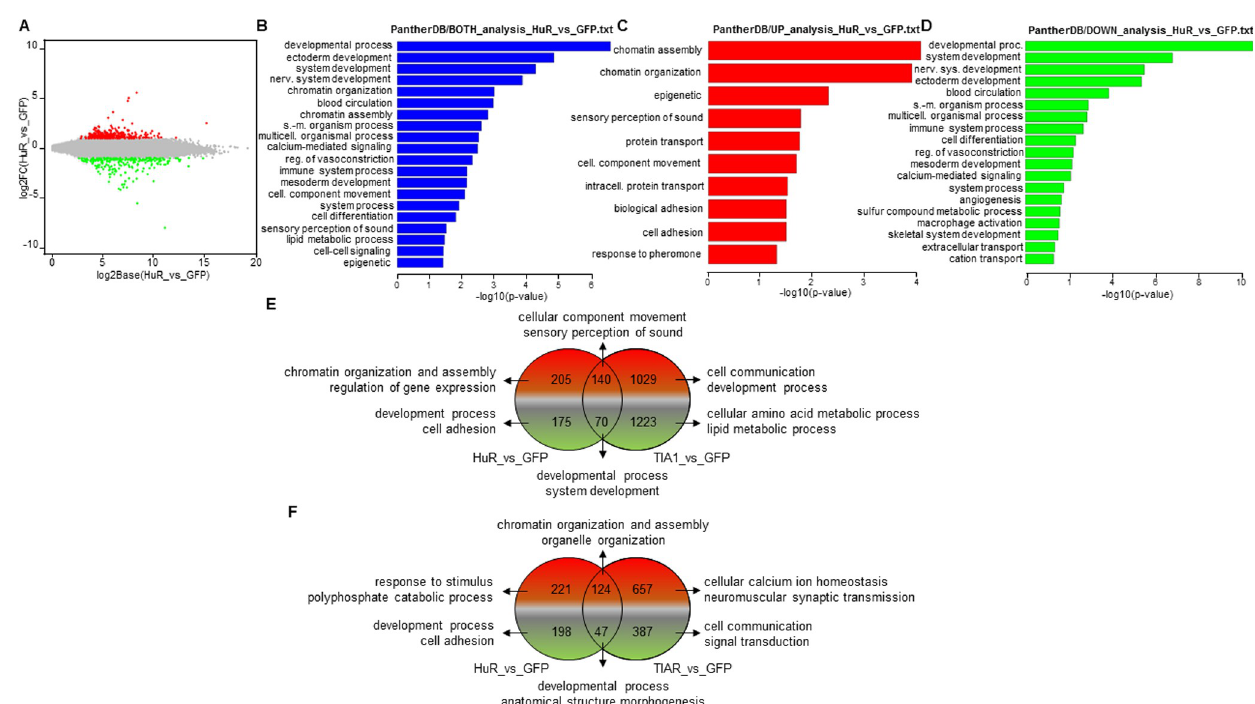
Fig 3. Gene Ontology (GO) analysis of differentially expressed genes (DEGs) in GFP- and GFP-HuR-expressing FT293 cells. (A-D) Top categories of biological processes associated with DEGs. (A) MA plot representations of the distributions of up- (spots in red) and down- (spots in green) expressed genes (-1 � log fold change � 1; FDR < 0.05) in the corresponding combinations indicated in A panel. (B-D) Histograms of the distributions of up- and down- regulated genes (B), only up-regulated genes (red in C) and only down-regulated genes (green in D) in the corresponding combinations using the GO PANTHER database ( P < 0.05). (E and F) Venn diagrams displaying numbers and GO enriched categories of DEGs in the comparisons HuR vs GFP against TIA1 vs GFP (E) and HuR vs GFP against TIAR v s GFP (F) combinations.